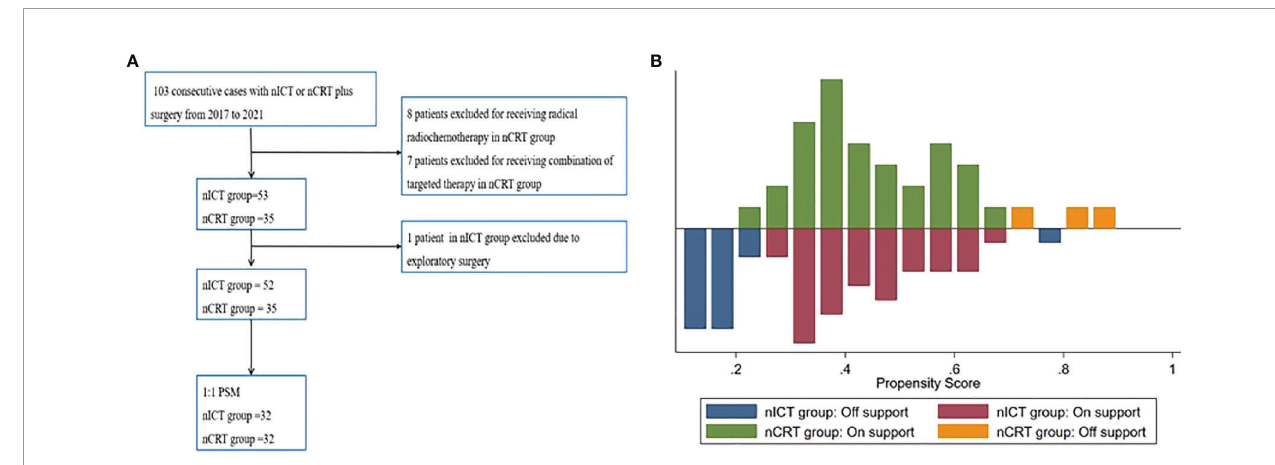
FIGURE 1 | (A) Patient selection fl owchart. (B) Mirrorhistogram ofpropensity scores for patients. PSM, propensity score matching; nICT, neoadjuvant chemotherapy and immunotherapy; nCRT, neoadjuvant